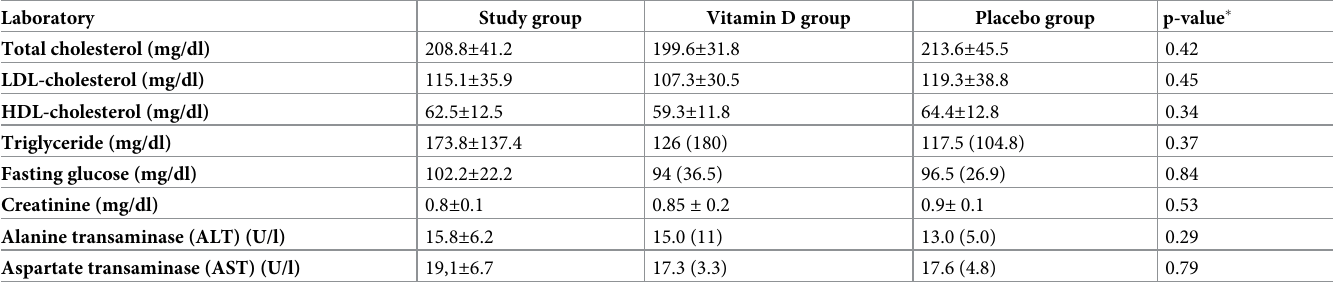
Table 3. Baseline biochemical characteristics of subjects.